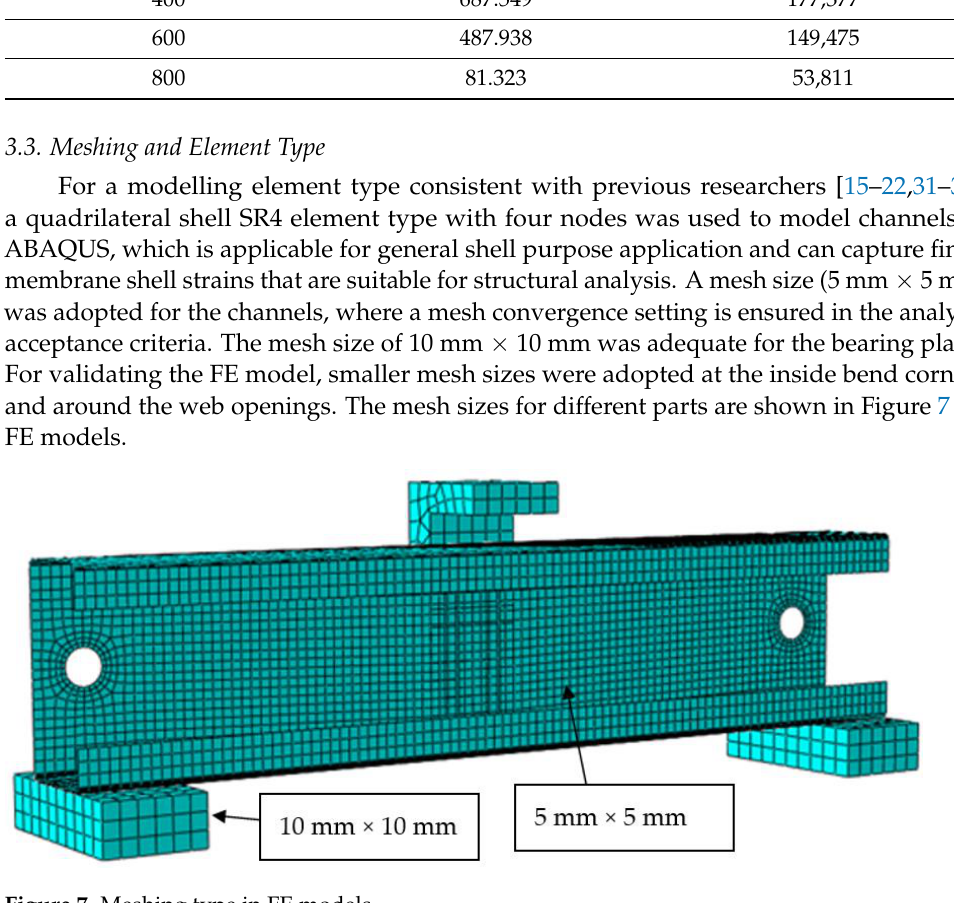
Figure 7. Meshing type in FE models.